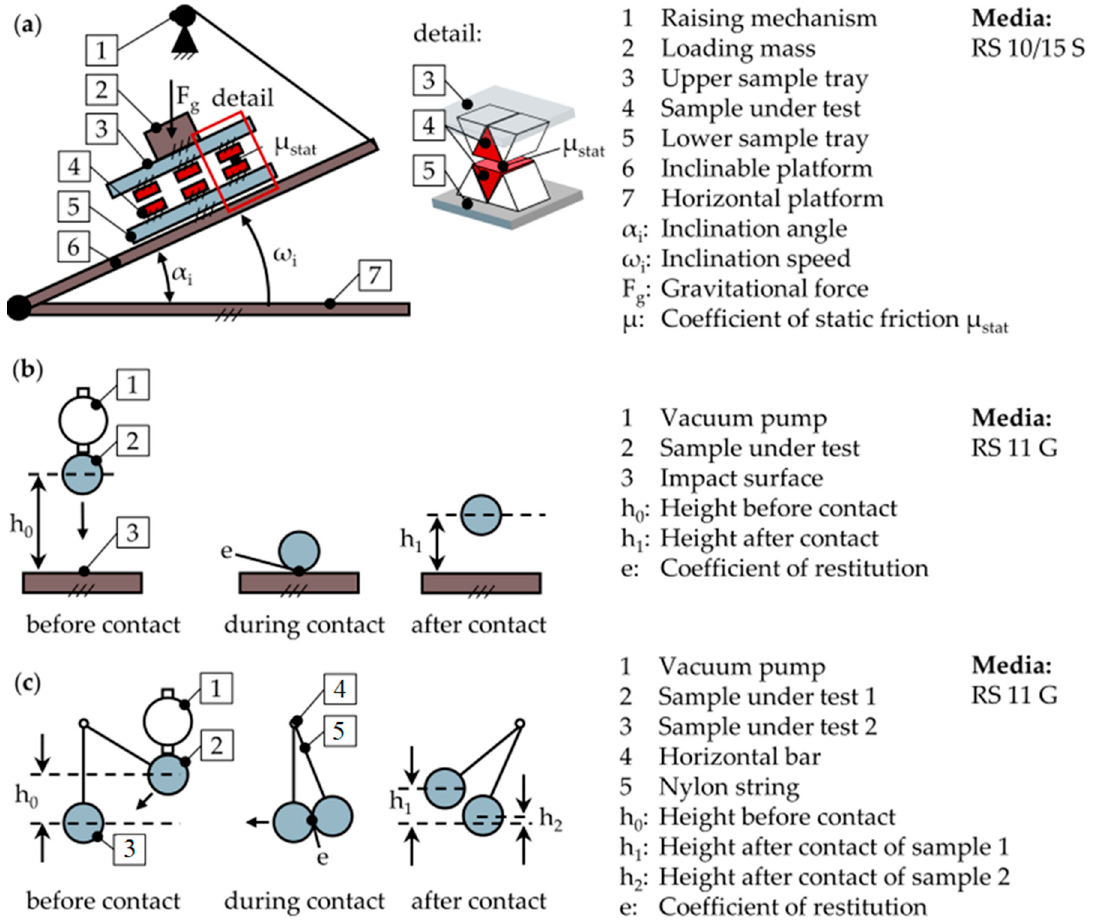
Figure 6. Experiments of DEM parameter determination: ( a ) inclined plane; ( b ) drop test; ( c ) double